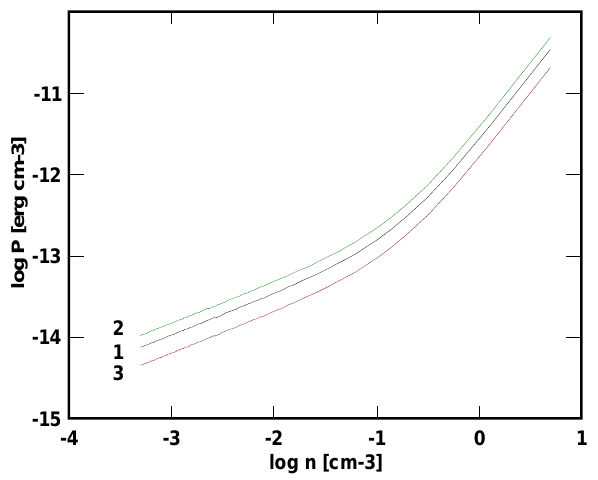
Fig. 2. Plotted is the logarithm of the solar wind pressure P 1 versus the logarithm of the density n 1 at 3 = 1 · 10 − 3 and 1α = 50 for different values of T 1 , 0 , i.e. for 1: T 1 , 0 = 5 · 10 4 K, 2: T 1 , 0 = 7 · 10 4 K, 3: T 1 , 0 = 3 · 10 4 K .